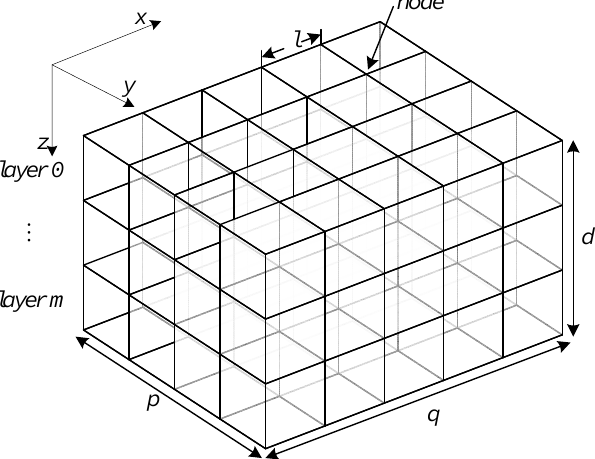
Figure 2. Coordinate system for the underwater three-dimensional